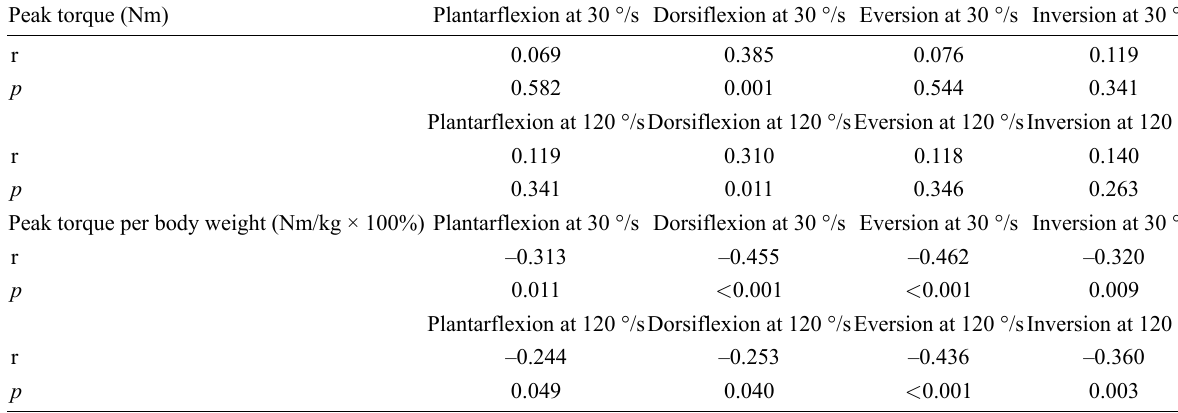
Table 5. Bivariate correlation coefficients (Pearson correlation coefficients) between BMI and parameters of the strength of muscles that move the